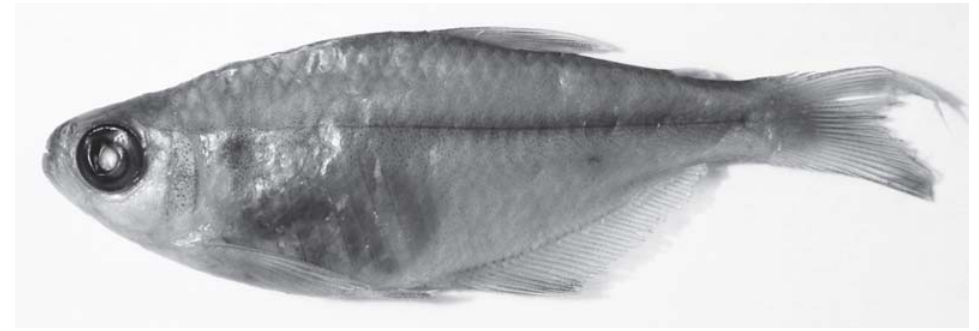
Fig. 1. Syntype of Hyphessobrycon melanopleurus uruguayensis Messner, 1962. MHNM 759, female, 33.2 mm SL.